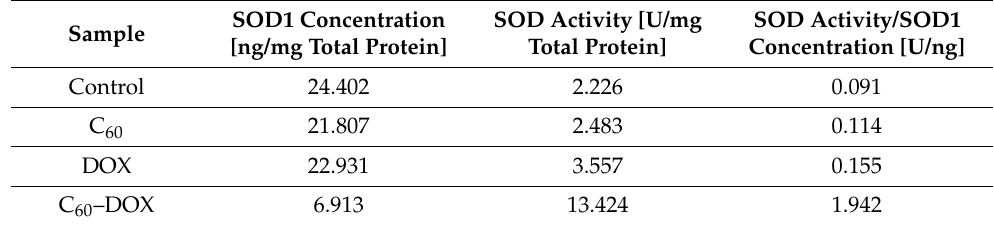
Table 1. SOD concentration and activity per total protein concentration and SOD activity per SOD1 concentration in MCF-10A cells treated with C 60 , DOX and C 60 –DOX